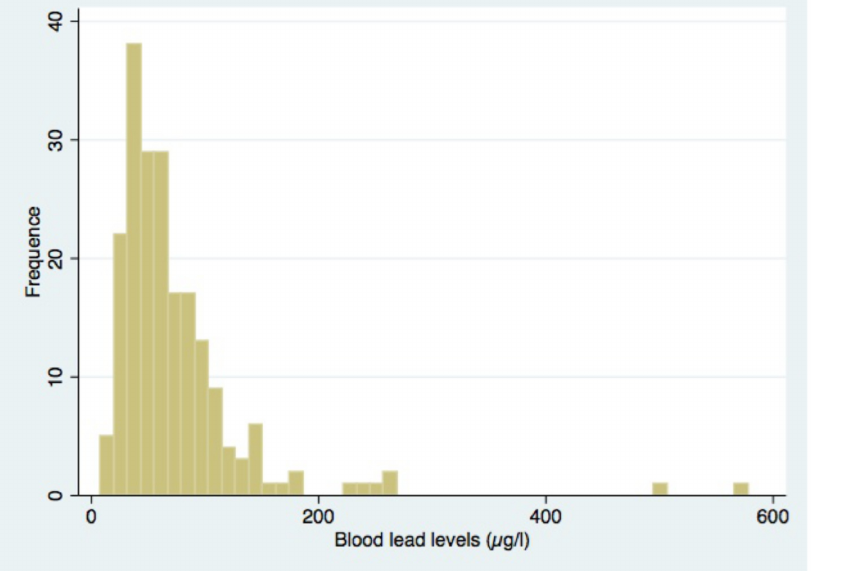
BLL between 3.9 – 5.8 μ g/dL, the 3 rd quartile includes infants with BLL between 5.8 – 8.7 μ g/dL, and the 4 th quartile includes infants with BLL between 8.7 – 57.8 μ g/dL. With regard to the hematological indicators, 144 infants were anemic (70.94%, hemoglobin < 110 g/L), and 85 were iron deficient (42.93%, CRP-corrected serum ferritin (SF)